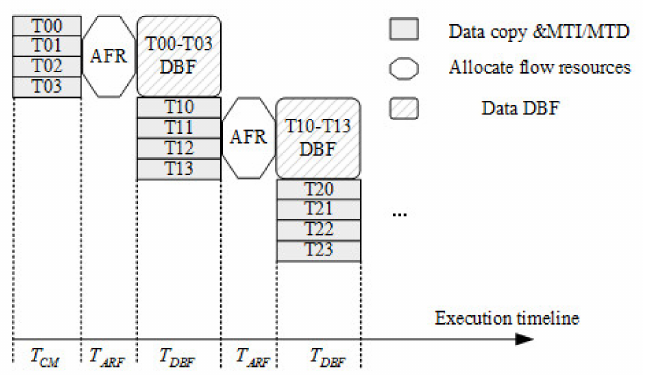
Figure 10. Stream parallel processing flow based on